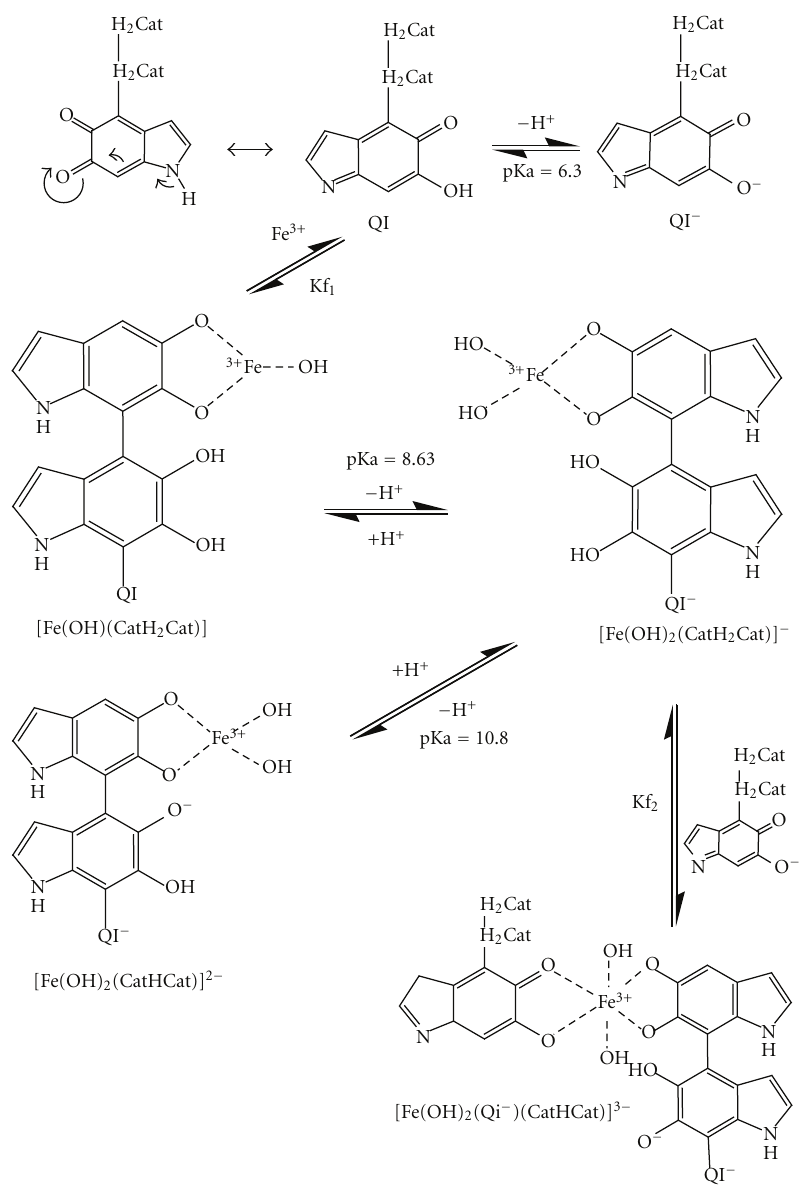
Scheme 1: Chemical equilibriums involving all of the species detected, where QI/QI- and H 2 Cat/HCat − /Cat 2 − are protonated and deprotonated forms of quinone-imine and catechol